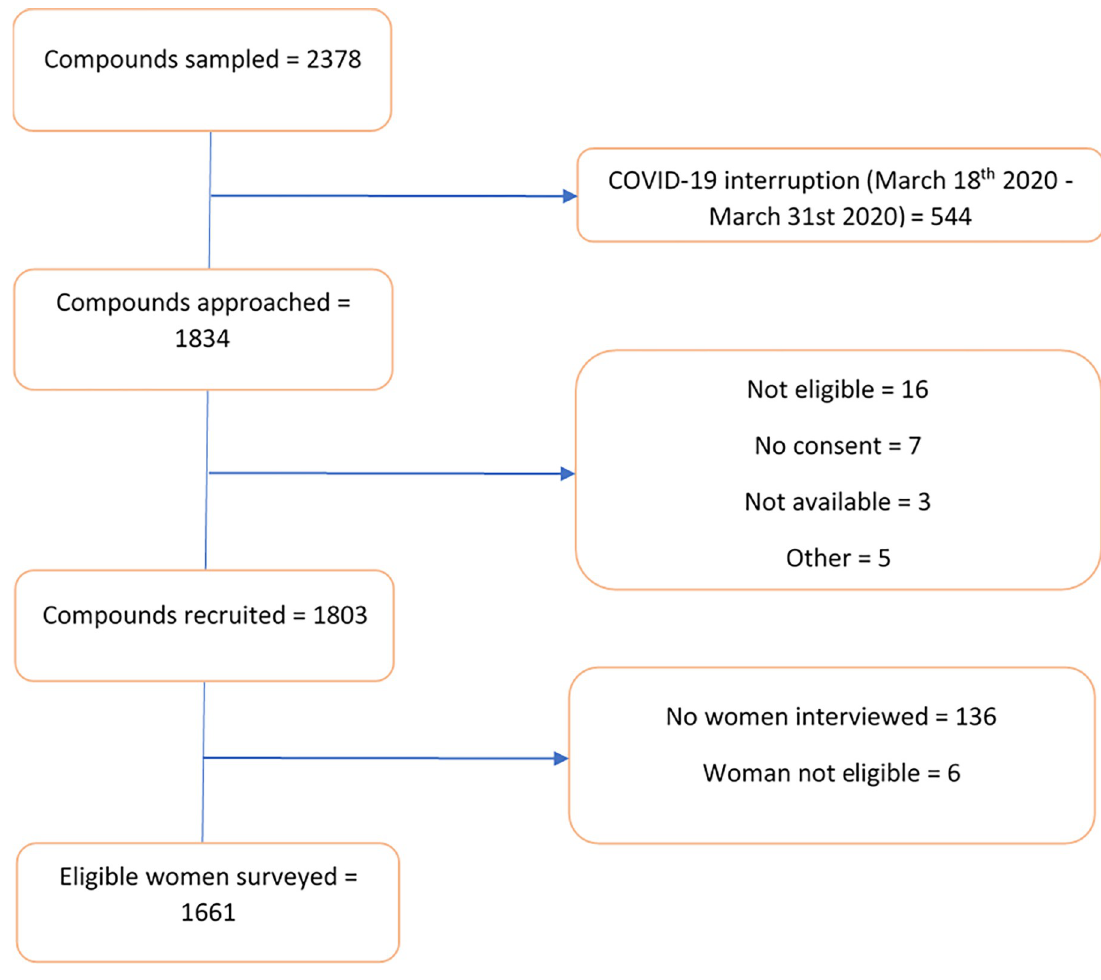
Fig 1. Participant inclusion flow